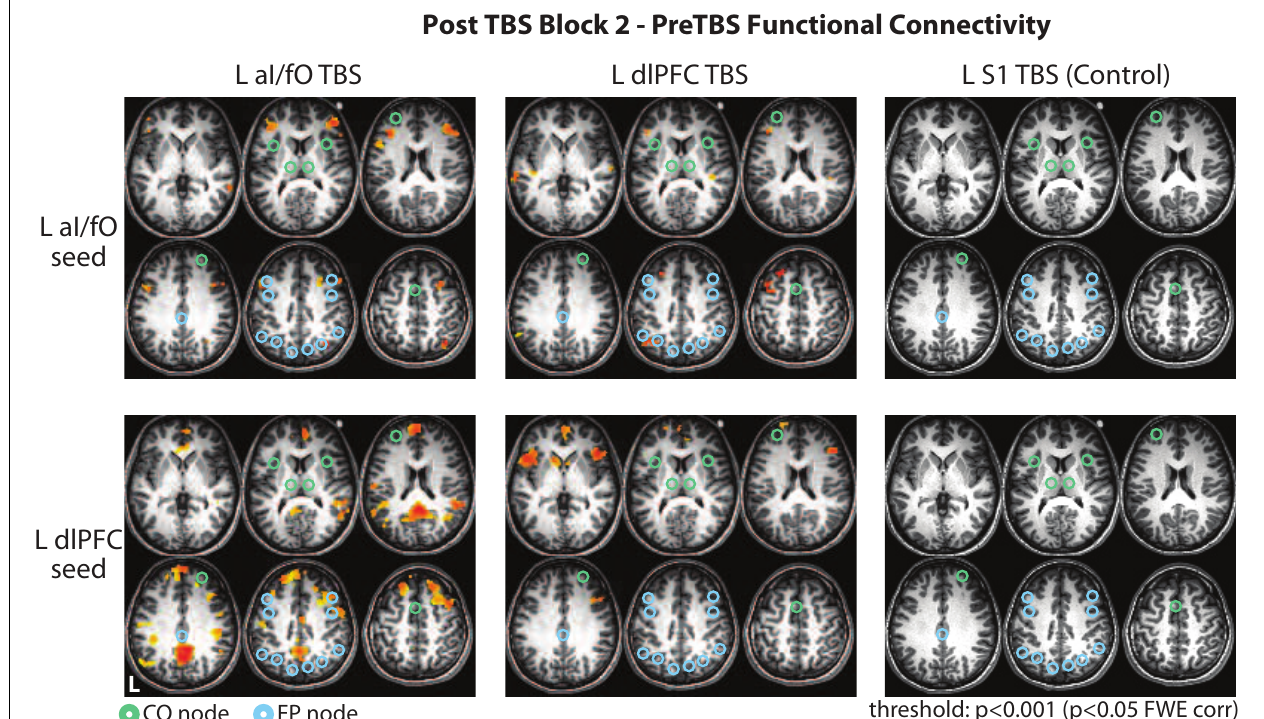
FIGURE 5 | Whole brain changes in connectivity after TBS. Changes in connectivity of the L aI/fO region ( Top row ) and L dlPFC region ( Bottom row ) to the whole brain in the second block after TBS are shown following TBS to L aI/fO ( Left column ), L dlPFC ( Middle column ), and L S1 ( Right column ). TBS to L aI/fO and L dlPFC led to widespread increases in connectivity